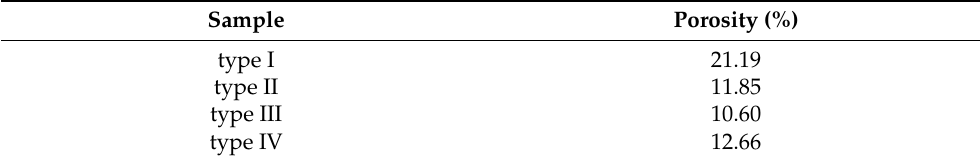
Table 6. Porosity of four types oxide